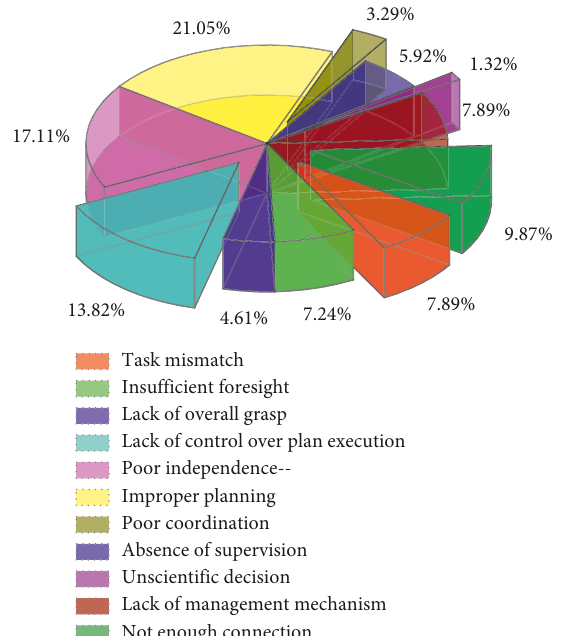
Figure 7: Proportion of various problems in audit program